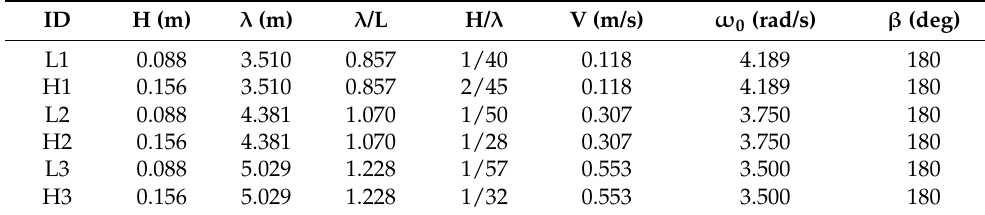
Table 8. The simulation conditions for case L1–L3 and